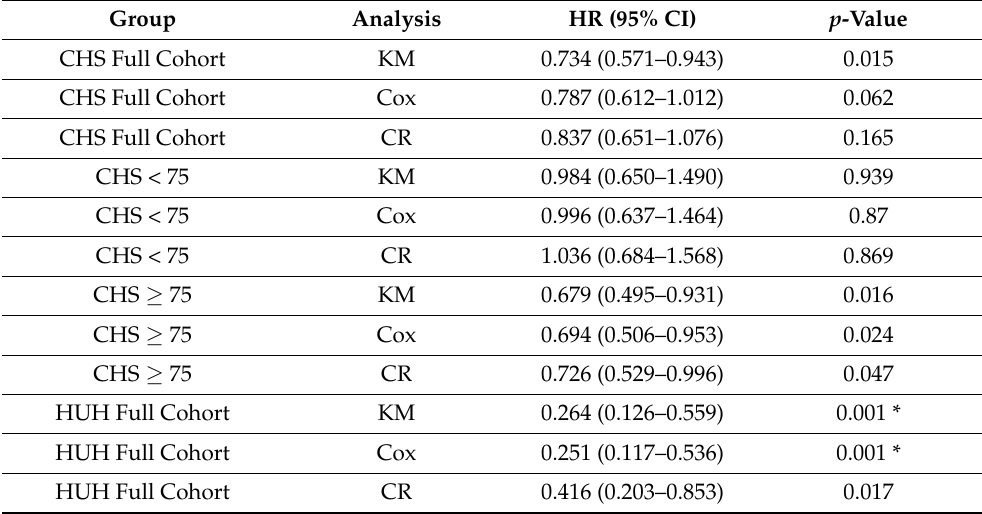
Table 3. Risk assessment of AD in CHS and HUH cohorts by Kaplan–Meier (KM), Cox proportional hazards regression (Cox), and competing risk analysis